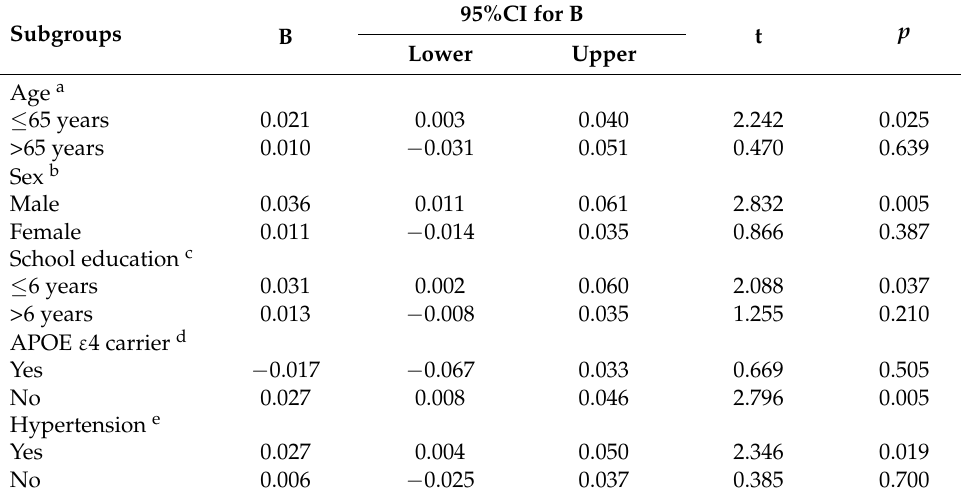
Table 4. Subgroup analysis of relationship between PP and ∆